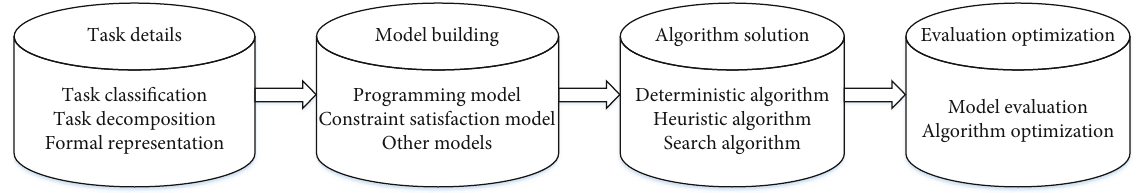
Figure 1: Flow chart of the four phases of mission planning.